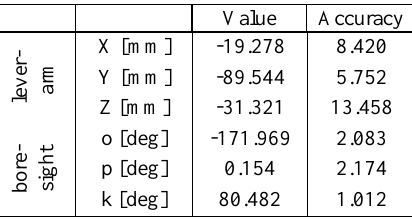
Table 3 . Results of the first feasibility study for boresight and lever-arm between platform camera and laser